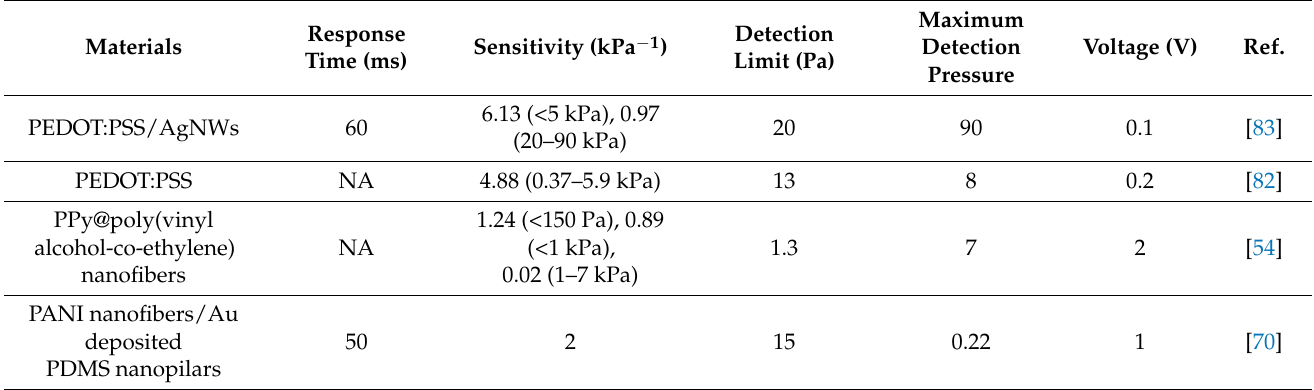
(Figure 4B) [83].Table 1 compare the key parameters of these two types PEDOT:PSS based strain flexible sensors with sensors based on PPy or PANI. Table 1. Comparison of key parameters in different polymer-based strain flexible